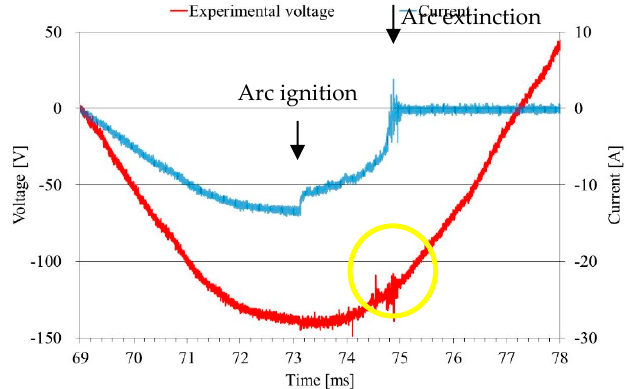
Figure 18. Sample voltage and current waveforms at disconnection of the intact element conductor.